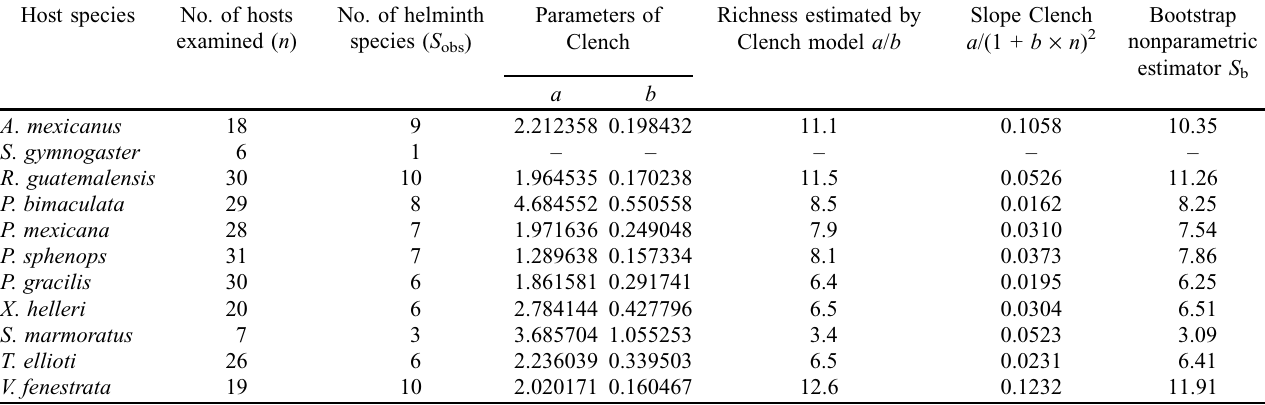
Table 2. Summary of the richness analysis and parameters of the cumulative curves of species for 11 component communities of helminths of freshwater fishes from Río Apazapan, basin of Río La Antigua, Veracruz, Mexico (in all cases the correlation coefficient R 2 between observed data and Clench’s model >